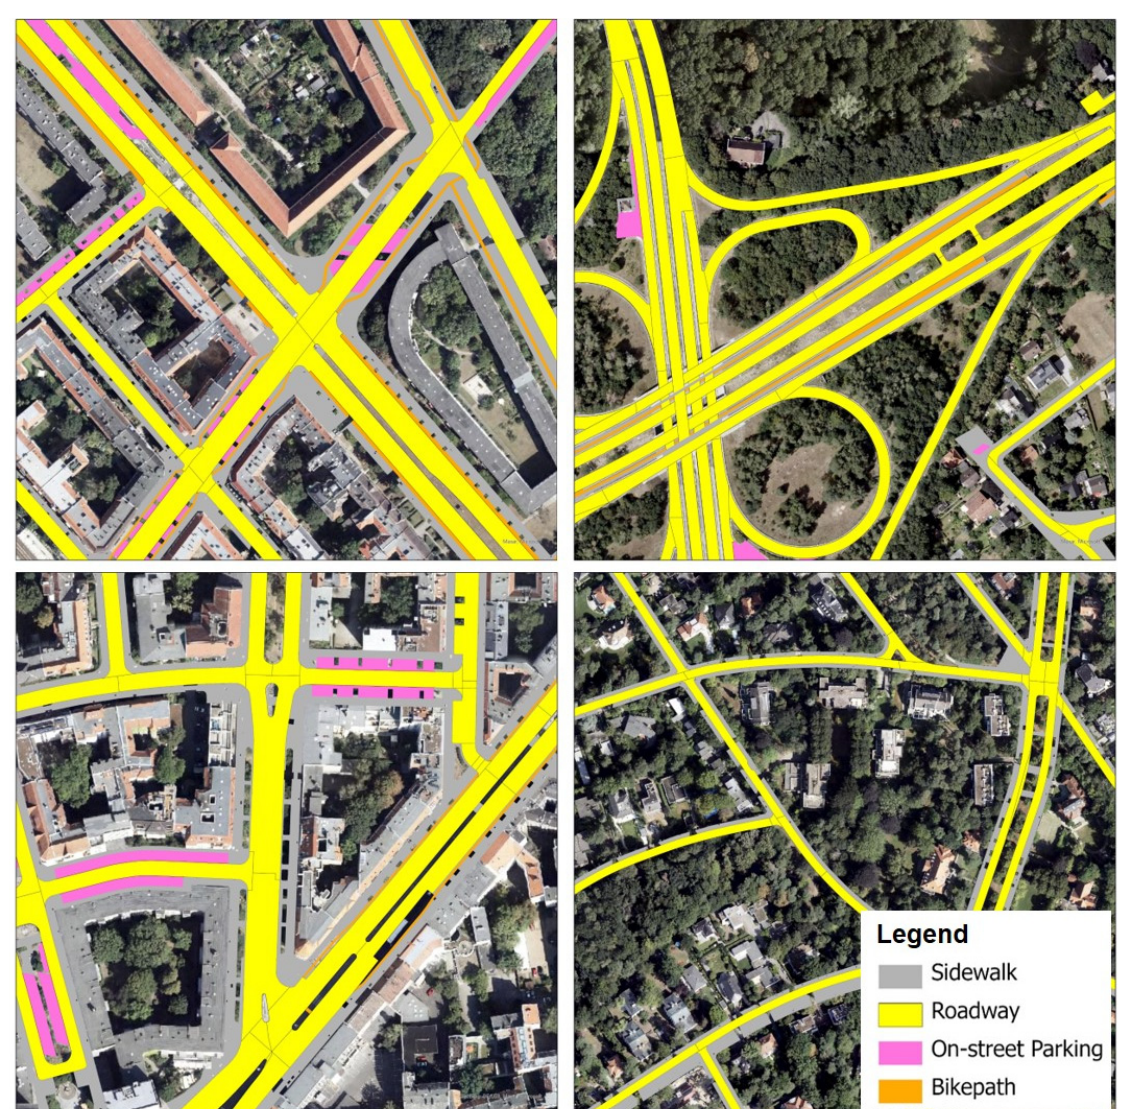
Figure 4. Common street features available in FIS-broker [45] dataset.